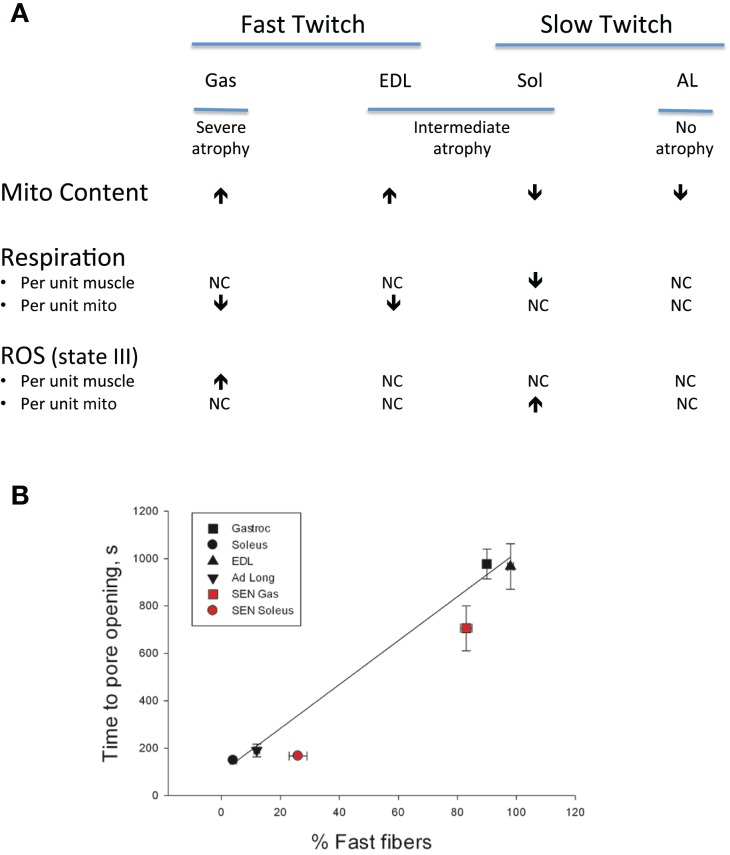
Impact of aging on mitochondrial function in saponin- permeabilized myofibers prepared from rat muscles of contrasting fiber type and atrophy susceptibility is shown. Gas = gastrocnemius muscle, EDL = extensor digitorum longus muscle, Sol = soleus muscle, AL = adductor longus muscle. (A) Impact of aging on mitochondrial content, respiration, and reactive oxygen species (ROS) emission responses. (B) Sensitivity of mitochondria to permeability transition following a calcium challenge and how this varies as a function of fast twitch fiber abundance. Solid black symbols represent the responses of young adult muscles, whereas the solid red symbols represent responses of senescent muscles. After taking into account the shift in proportion of fibers positive for fast myosin heavy chain with aging in each muscle, both the soleus and gastrocnemius muscles exhibit a sensitization to permeability transition. Data for mitochondrial content, respiration, ROS, and time to pore opening are taken from Picard et al. (2011a). Data for proportion of fibers positive for fast myosin heavy chain are taken from Carter et al. (2010).